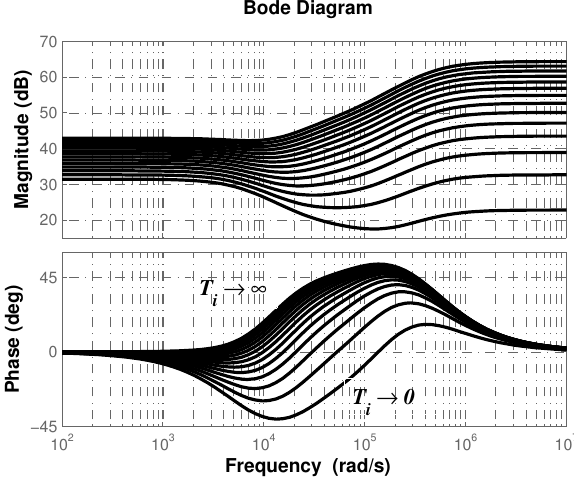
Figure 4. Transition between integral and derivative effect as function of T i